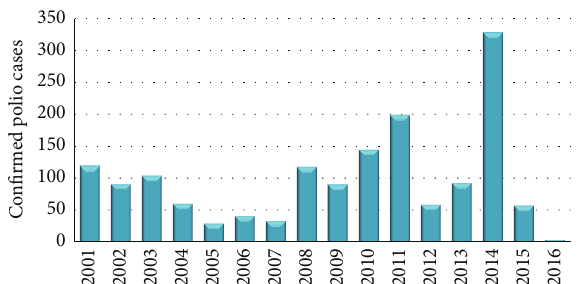
Figure 3: Number of confirmed polio cases (WPV + cVDP) in Pakistan from 2001 to February